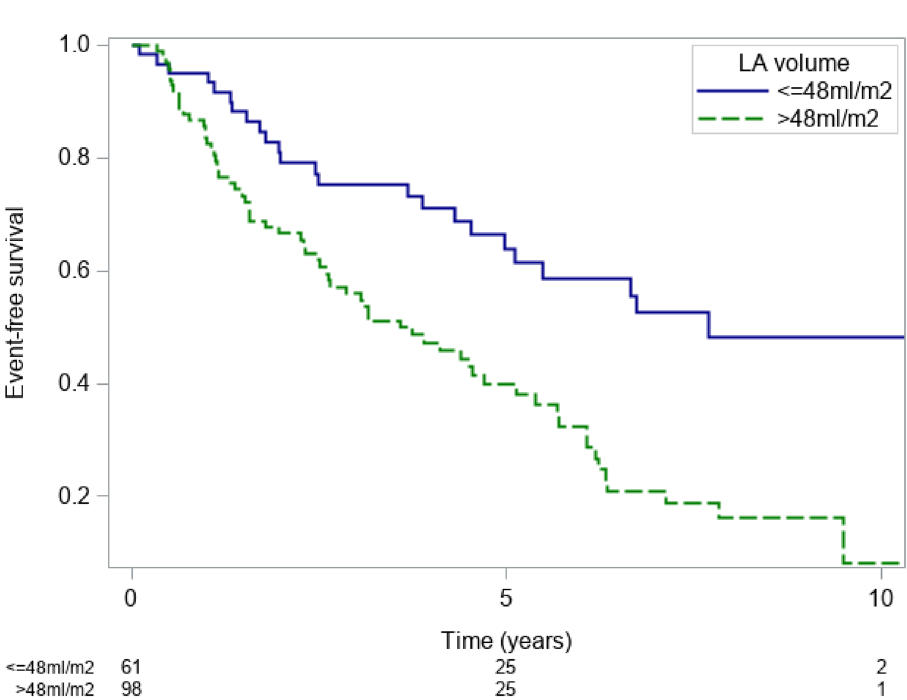
Figure 6. Kaplan–Meier event-free survival estimates patients included after beginning of 2005 with an indexed LA volume of ≤ 48 ml/m 2 (blue line) and > 48 ml/m 2 (green